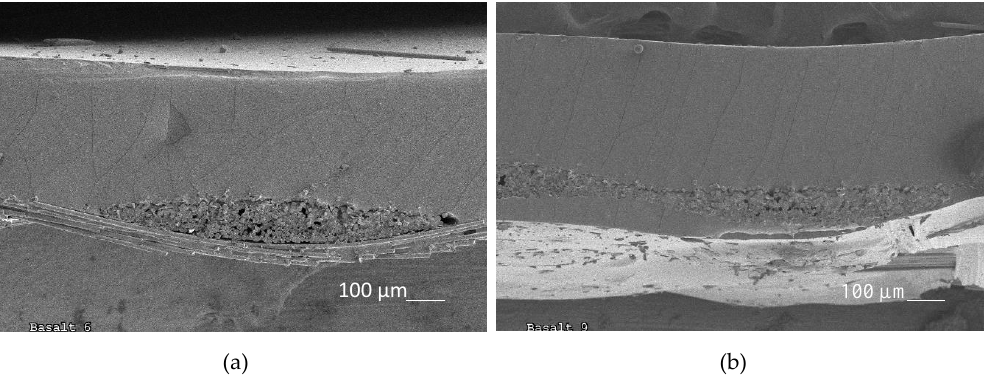
Figure 1. Scanning electron microscopy (SEM) images of ( a ) Basalt 6 and ( b ) Basalt 9 sections showing greater penetration of the silicone into the fabric at a higher add-on. Table 1. Details of mass per unit area and silicone add-on ( W c − W uc ) of un-sized and plasma-treated basalt fabrics coated with different silicone content (CR (%)).